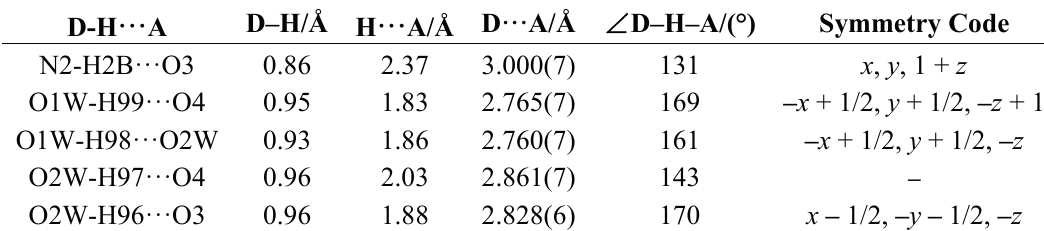
Table 1. Hydrogen bonds data of 1